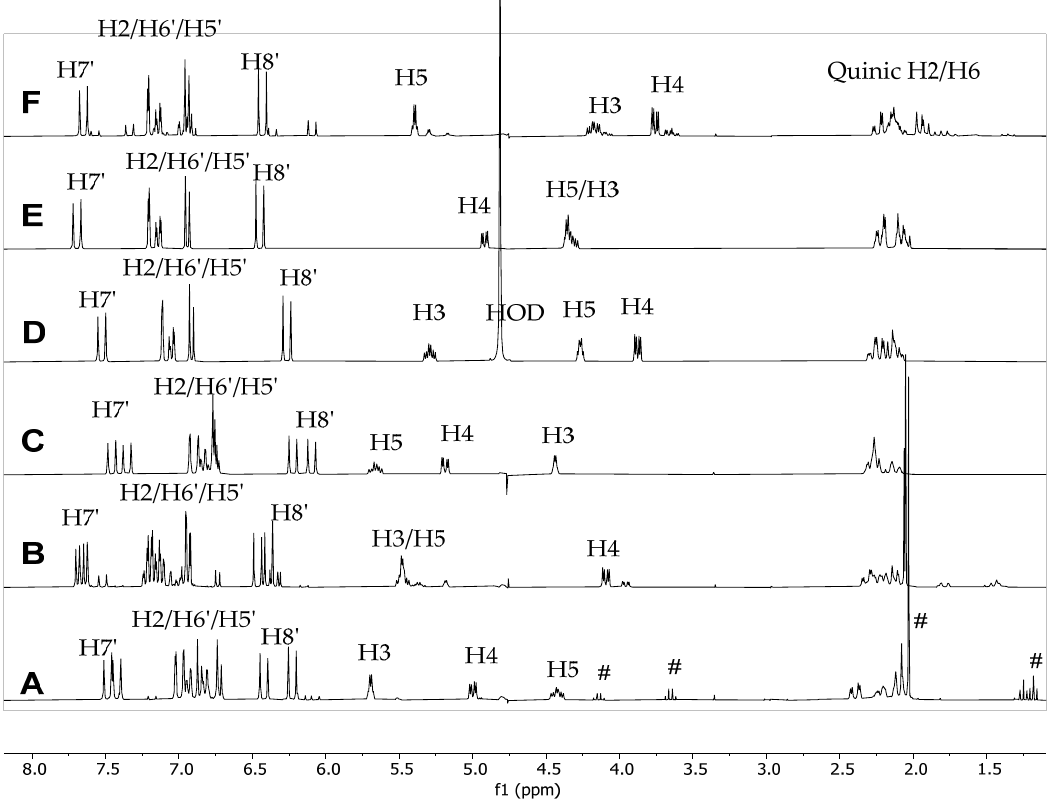
Figure 4. 1 H NMR stacked plot comparison of six chlorogenic acids investigated in this study without the addition of caffeine ( A ) 3,4-diCQA, ( B ) 3,5-diCQA, ( C ) 4,5-diCQA, ( D ) 3-CQA, ( E ) 4-CQA and ( F ) 5-CQA . # indicates ethanol and ethyl acetate residual solvent.